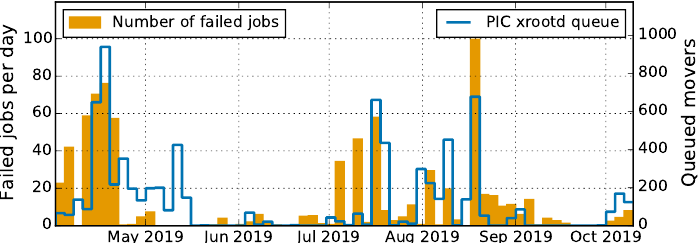
Figure 6: Number of failed jobs (orange bars) vs queued xrootd movers at PIC (blue